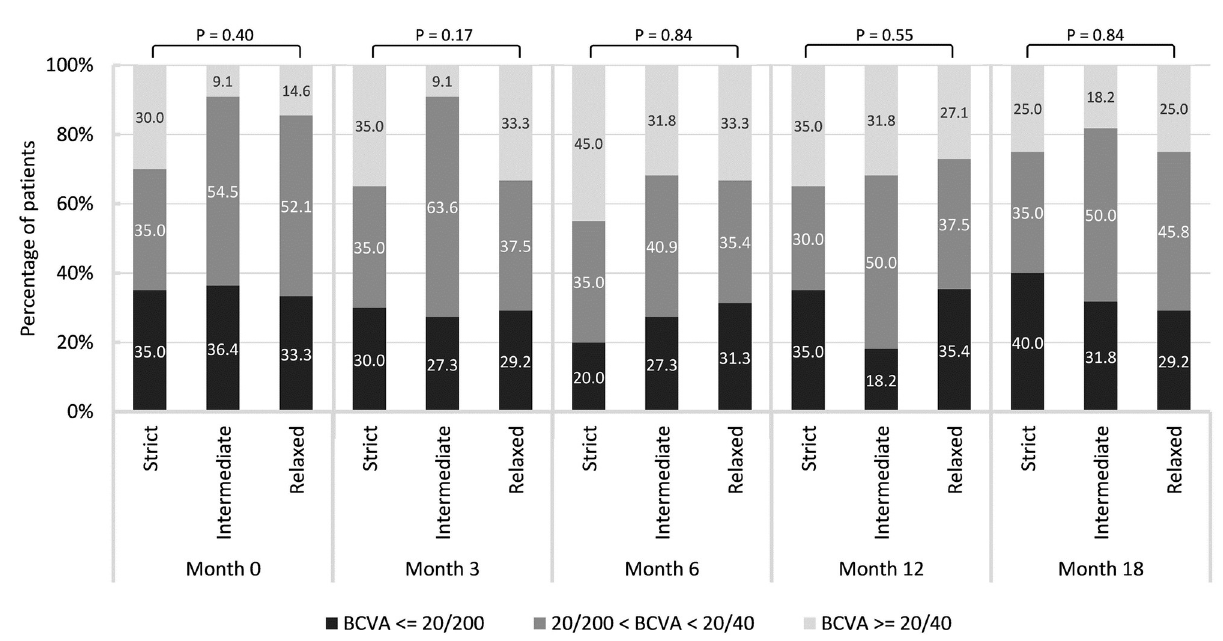
Fig 2. BCVA among strict, intermediate, and relaxed groups at various time points.